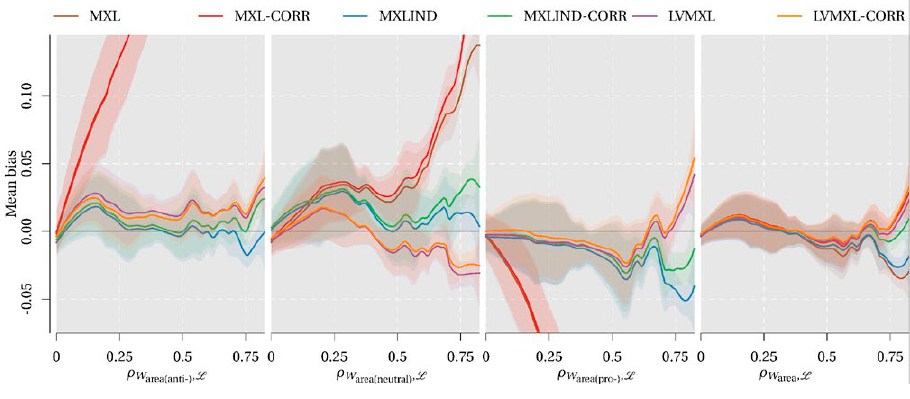
Figure 4. Mean bias in MWTP broken down by anti-, neutral and pro-environmental tendencies for area.